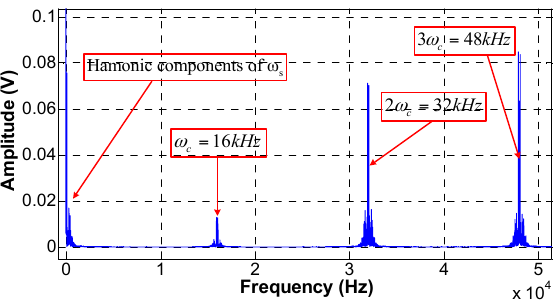
Figure 3. Photodetector signal of optical interference within channel 1 in the frequency domain.